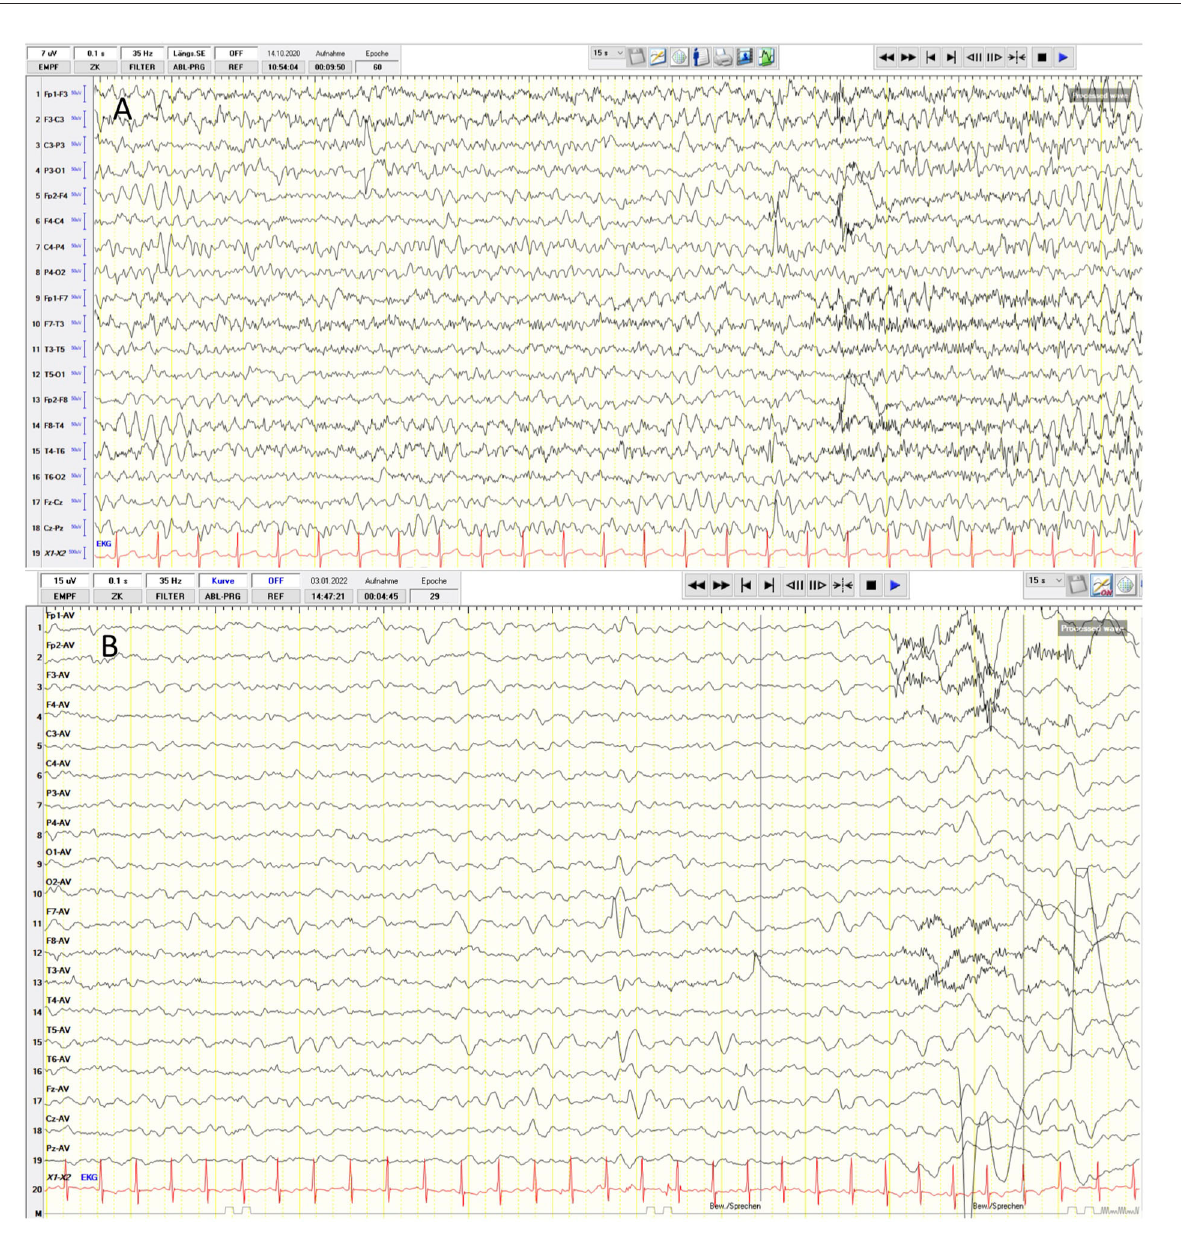
FIGURE2 (A) Routine electrophalography (EEG) reveals focal sharp-waves (left, frontoparietal), rhythmic 6Hz electrical activity and signs of focal cerebral dsfunction with a frontal theta-waves slow activity in the frontal area. (B) The EEG examination of patient 2. Frontotemporal